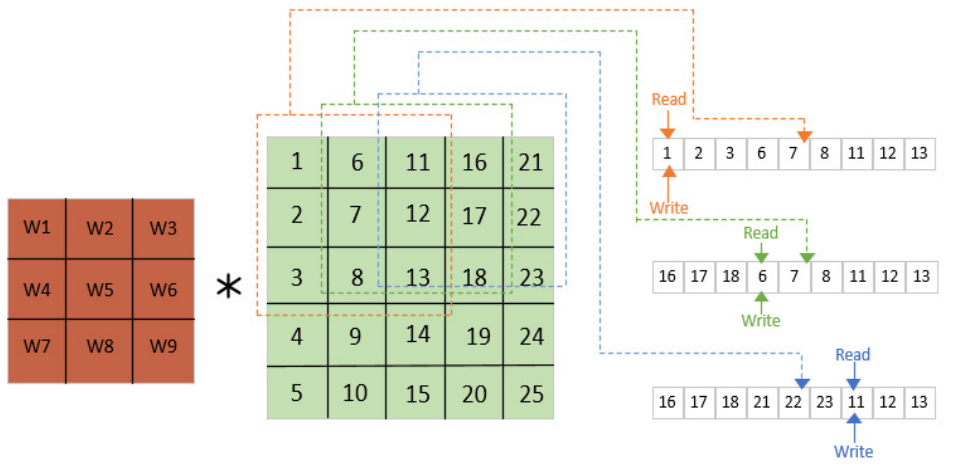
Figure 6. Process of convolutional data loading.